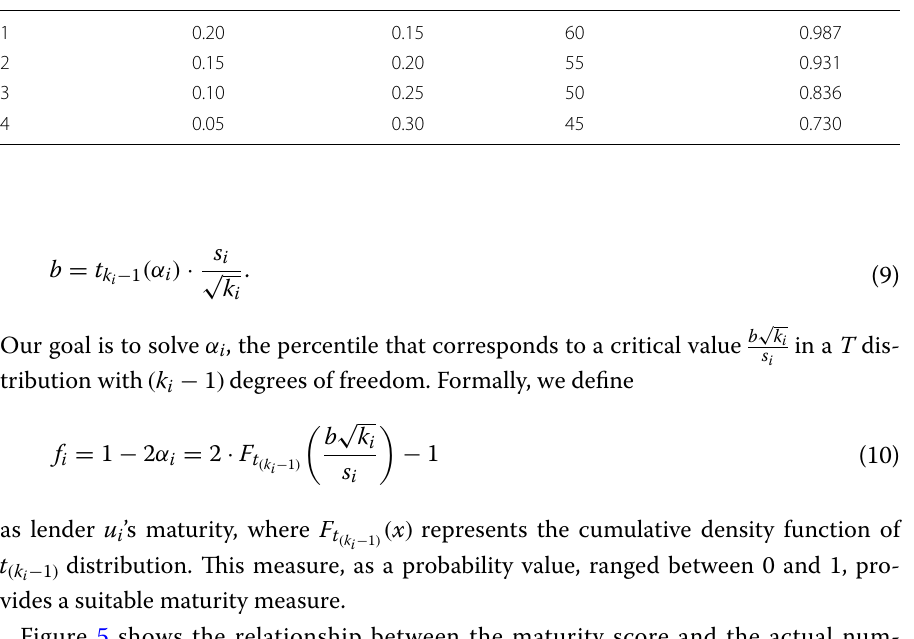
Table 1 Examples of lender maturity calculation y i ) Risk ( s Lender ( i ) Return ( i ) Experience ( k i ) Maturity ( f i ¯